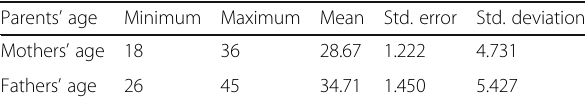
Parents ’ age Minimum Maximum Mean Std. error Std. deviation